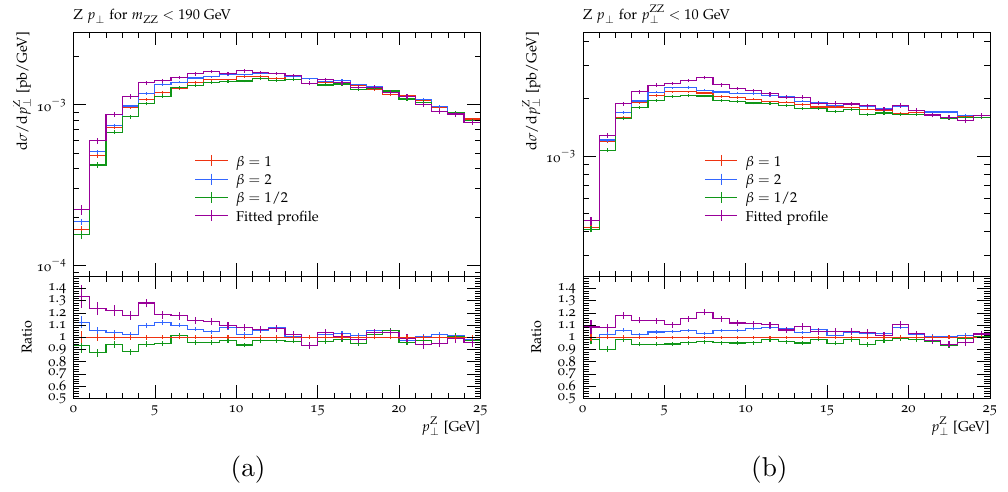
Figure 14 . Transverse momenta of the Z 0 bosons with (a) a cut on the invariant mass of the Z 0 Z 0 pair and (b) a cut on the transverse momentum of the pair. The results were produced using equation (3.22) for a Gaussian form of g ( k ? ; y ) (with several values of (cid:12) ) and for a decreasing Gaussian form ((cid:12)tted pro(cid:12)le). The (cid:12) = 1 setup is the reference in the ratio plots. The histograms are not normalised to